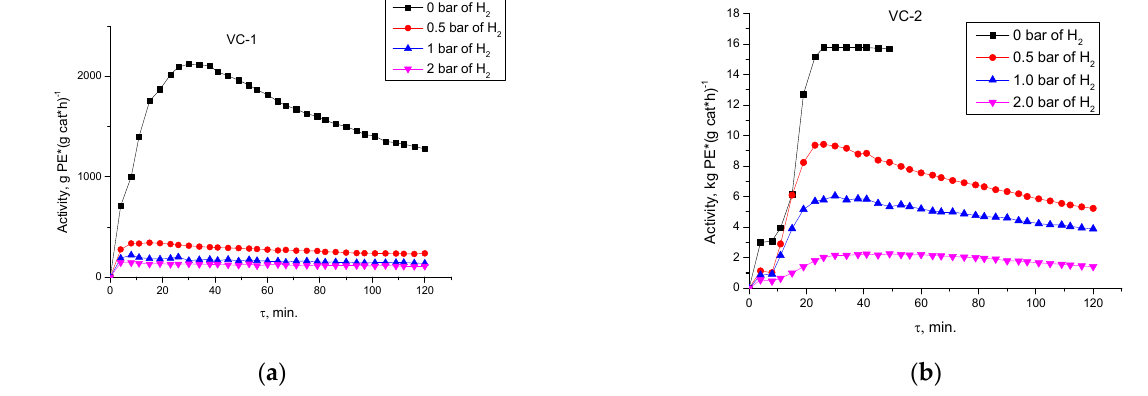
Figure 1. The effect of hydrogen content on the shape of kinetic curves of ethylene polymerization over the “low ‐ loading” VMC (VC1) ( a ), and “high ‐ loading” VMC (VC2) ( b ) (polymerization condi ‐ tions are listed in Table